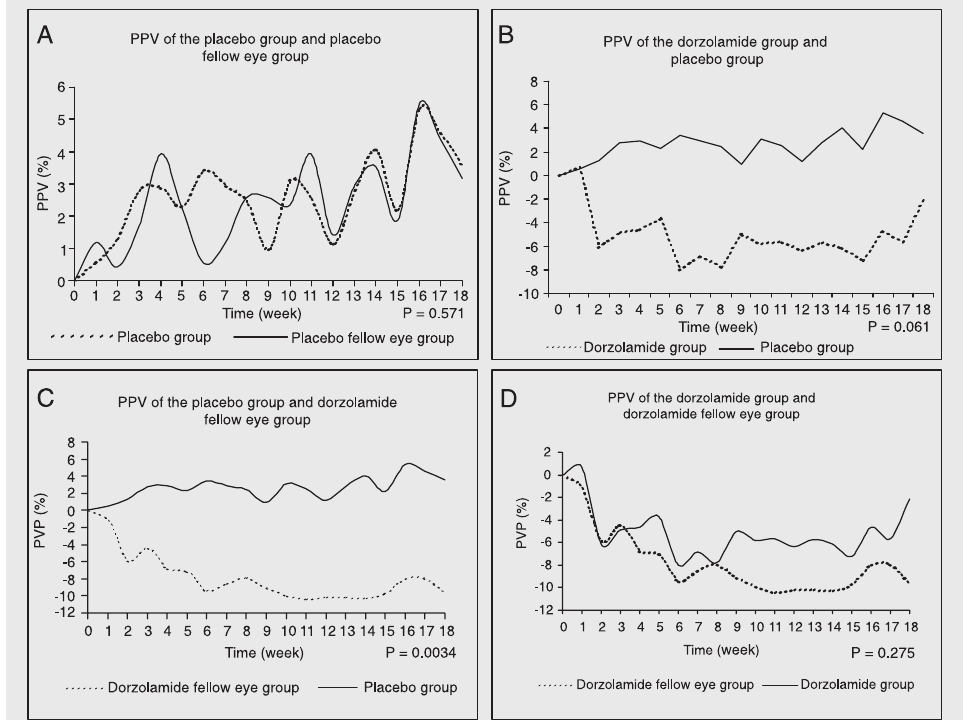
Figure 1. Graphic presentation of percent pachymetric variation (PPV) in the four groups studied over a period of 18 weeks. See legend to Table 1 for identifica- tion of the